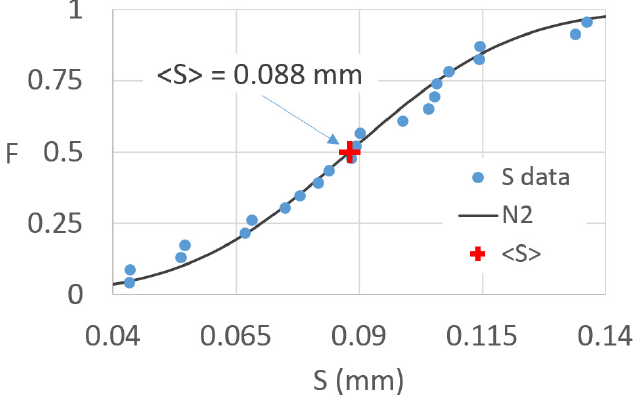
Figure 2. For the considered 22 runs, frequency distribution and normal distribution, N2, of the interception capacity, S . The mean value < S > is also indicated.